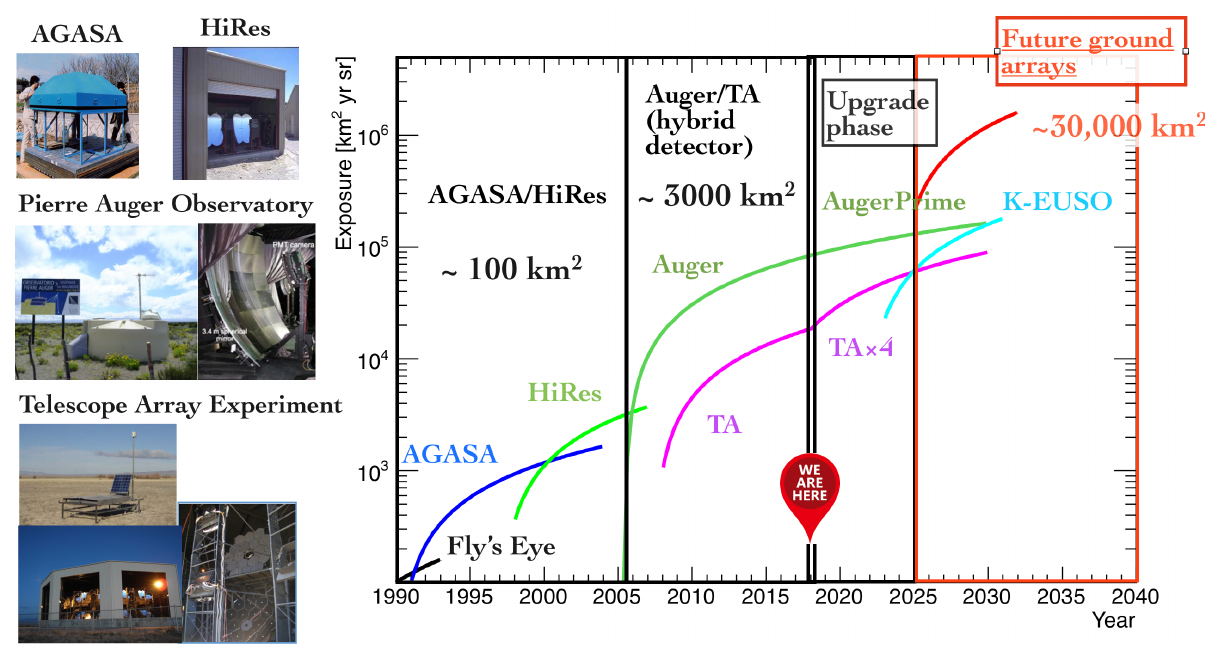
Figure 4. The UHECR observatories and their exposures at the highest energies as a function of time; including AGASA [29], High Resolution Fly’s Eye [30], Auger [16], TA [17, 18]. The pioneering detection of UHECRs from space, K-EUSO [31], is also